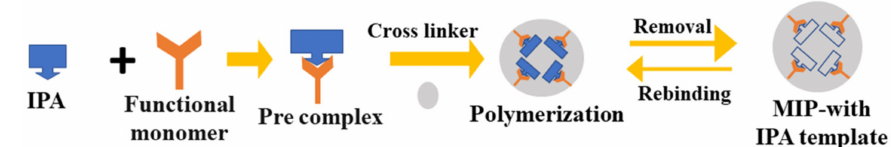
Figure 1. Schematic diagram of the synthesis procedure.